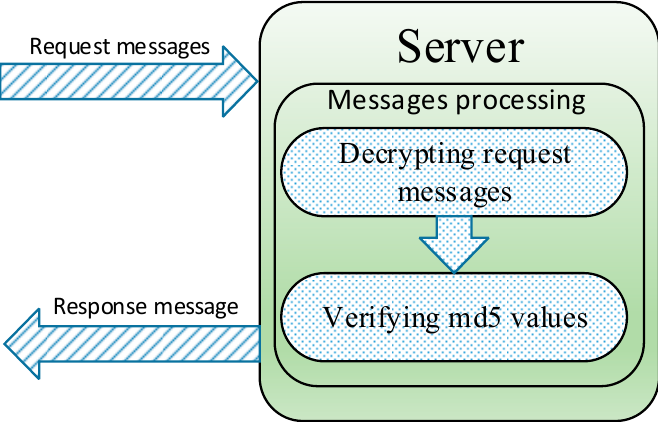
Figure 30. Generated model of the QQ mail system server-side.